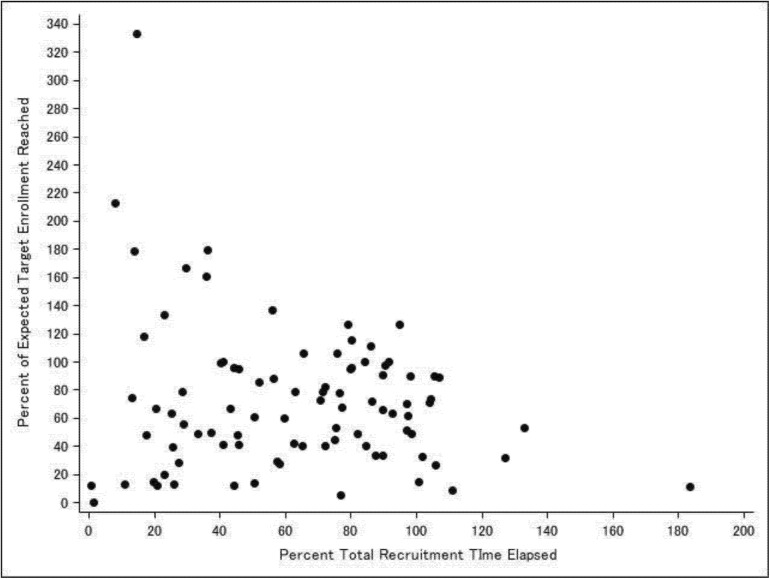
Scatterplot of percent of expected target enrollment reached by percent of total recruitment time elapsed for actively recruiting protocols.